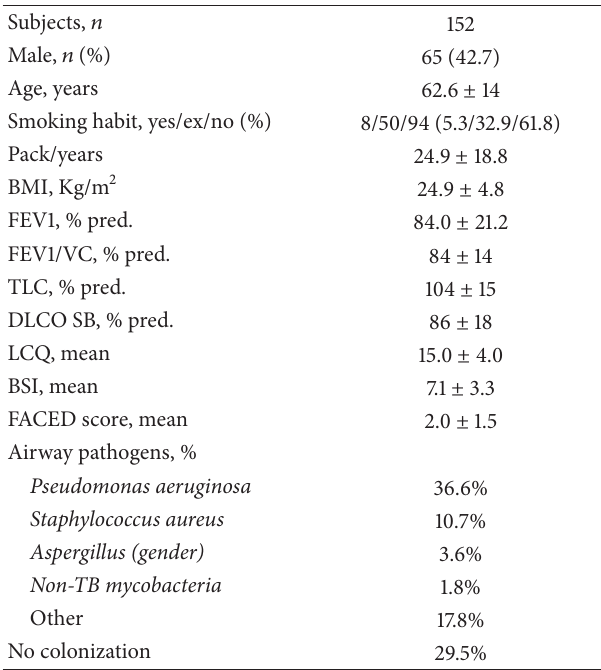
Table 1: Main clinical and functional data of the examined patients with NCFB.